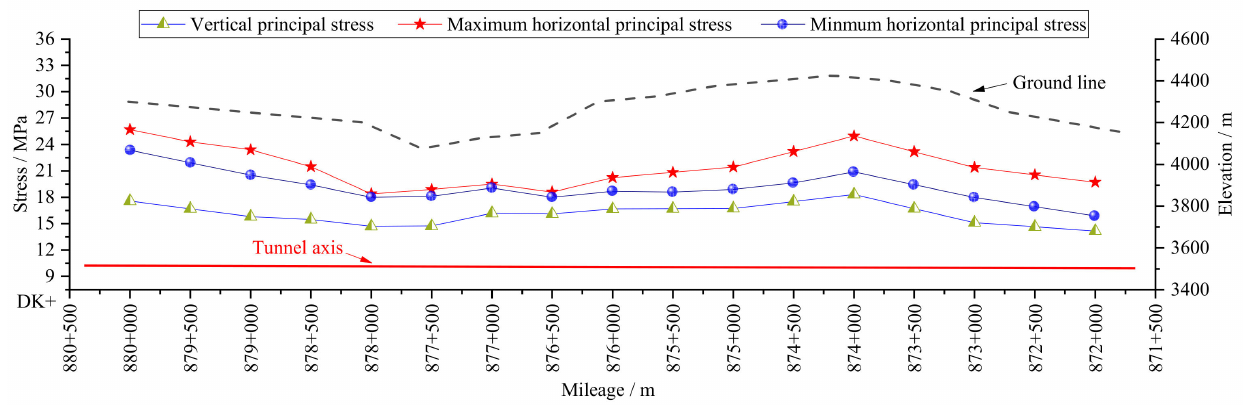
Figure 6. Principal stress distribution at different buried depths along the